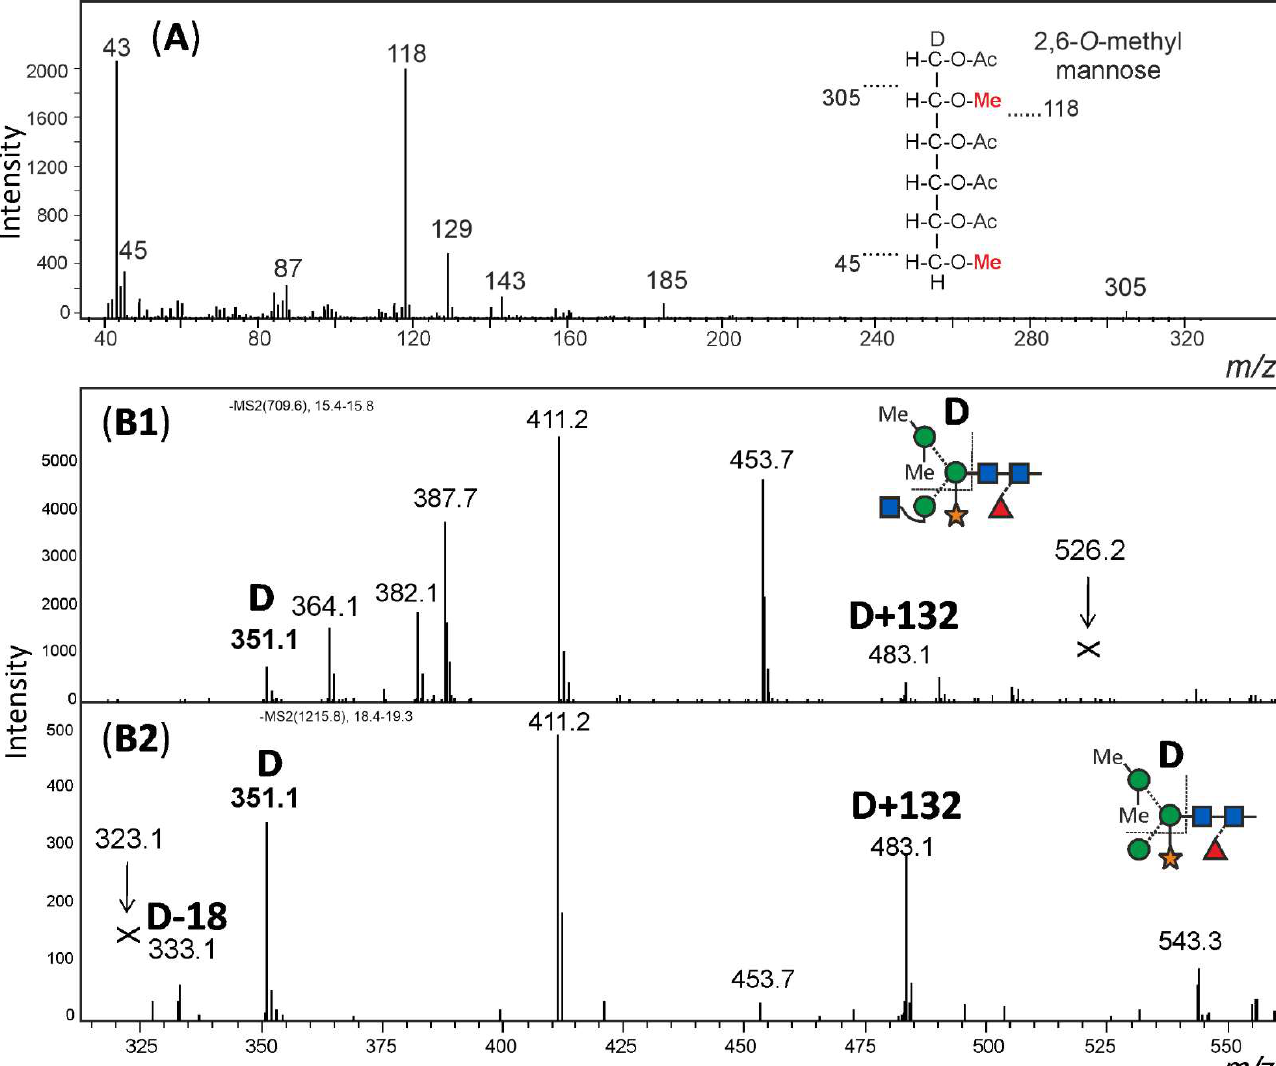
Figure 5. Structural analysis of methylated N-glycans. Panel ( A ): The HILIC fractionated main glycan from Funaria hygrometrica was hydrolysed, reduced and peracetylated. The fragment peaks in GC-MS analysis identified the methyl mannose as 2,6-di- O -methylation, which fits the retention time of that peak (Figure S5). Panels ( B1 , B2 ): The arm location of the methylated mannose was defined by observing the D-ion generated by negative mode collision induced dissociation. Notably, the xylose substituting the β-mannose residue was partially retained on the D-ions. Arrows pointing at Andrew’s crosses denote the theoretical positions of D-ion for the alternative branch arrangement.